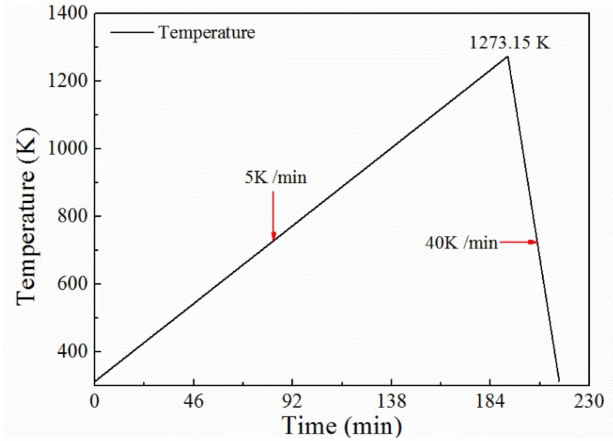
Figure 3. Heating system of the thermogravimetry (TG) experiment.